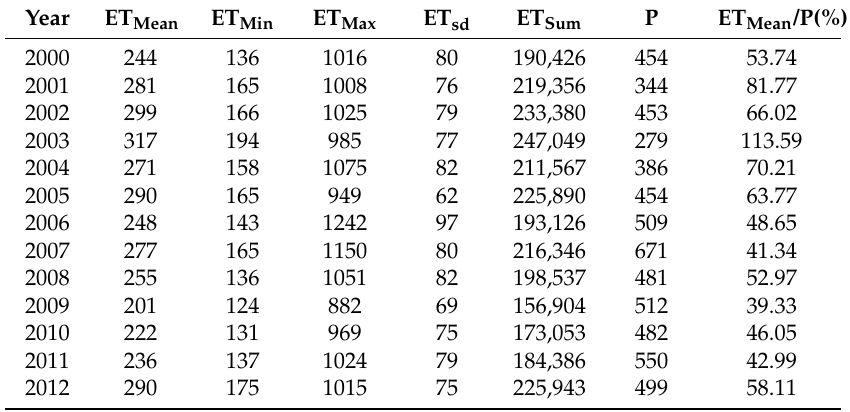
Figure 5. The interannual dynamics of forest ET simulated by the SEBS over the QMs from 2000 to 2012. Table 3. The statistics for interannual simulated forest ETs and precipitation (unit: mm·year − 1 ) downscaled from WRF estimates over the QMs from 2000 to 2012.